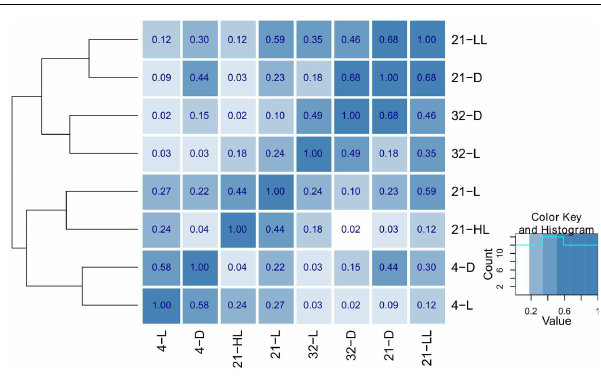
FIGURE 3 | Heatmap and hierarchical clustering illustrating the similarity of the eight environmental conditions. The pairwise similarity is derived using the R V coefficient of the corresponding cross-product matrices obtained for each condition.The hierarchical clustering was obtained using average linkage on the pairwise distances obtained using 1 − R V